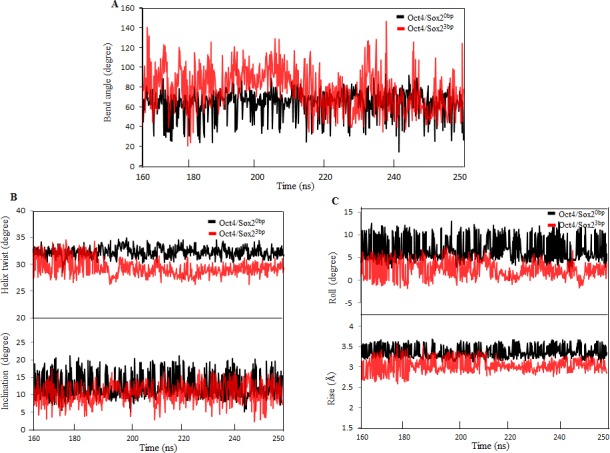
Comparison of DNA parameters.(A) DNA-bend angles for the Oct4/Sox20bp and Oct4/Sox23bp complexes. (B) Helix twist and inclination for the Oct4/Sox20bp and Oct4/Sox23bp complexes. (C) Rises and rolls for the Oct4/Sox20bp and Oct4/Sox23bp complexes. Black represents the Oct4/Sox20bp complex, and red represents the Oct4/Sox23bp complex.